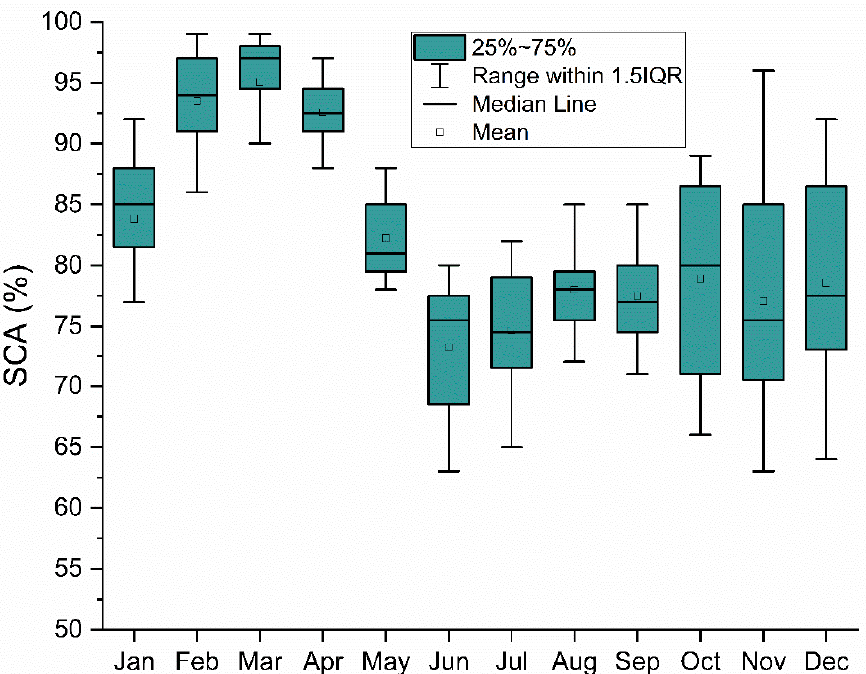
Figure 4. Monthly variation of snow cover area (SCA) in Langtang basin during the research period (2002–2012).